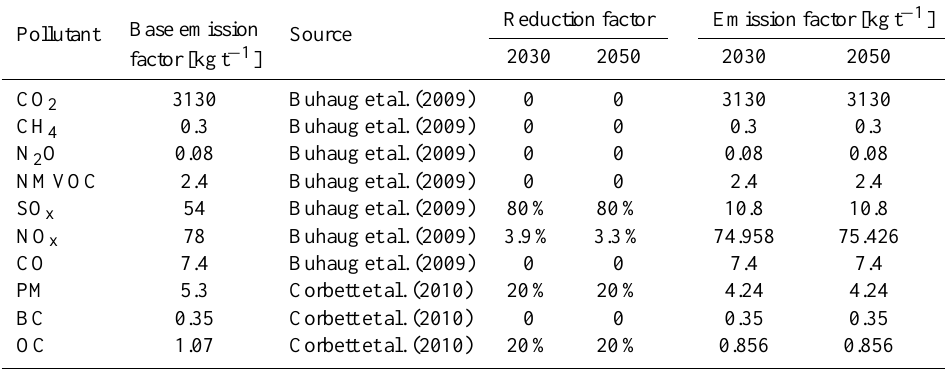
Table 4. Base emission factors in kg emitted per tonne of fuel consumed for an internal combustion engine running on residual fuel oil, as well as emission reduction factors and corresponding emission factors for different pollutants for the years 2030 and 2050, based on the revised MARPOL 73/78 Annex VI effective as of 1 July 2010.